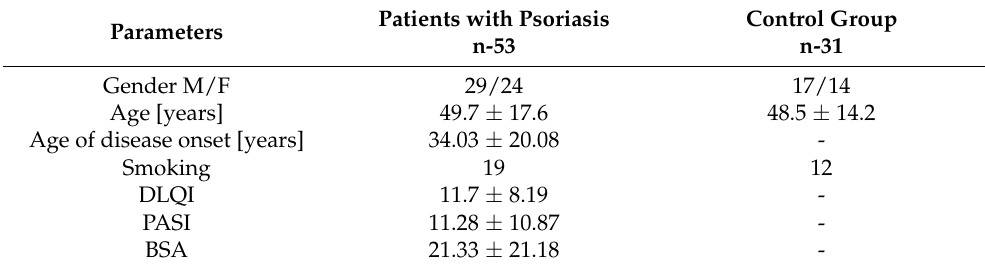
Table 1. Clinical characteristics of patients and control group.